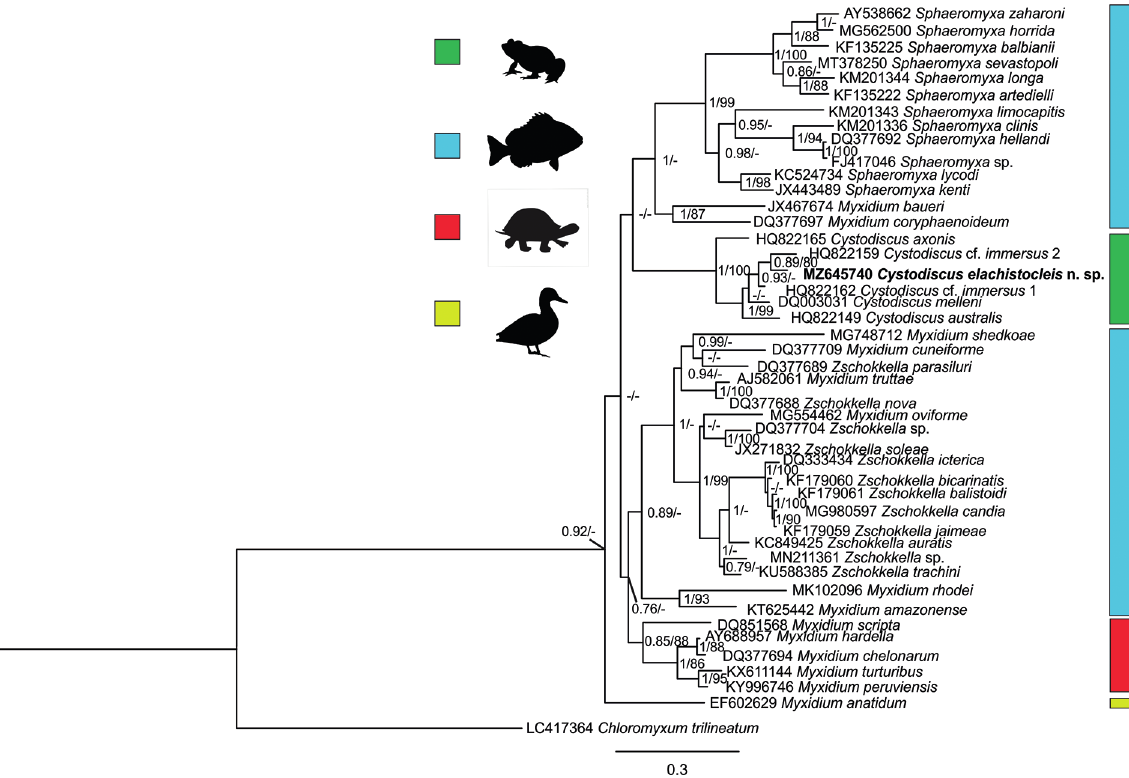
Fig. 3. Phylogenetic tree of Bayesian analysis based on partial SSU rDNA partial sequences showing the position of Cystodiscus elachistocleis sp. nov. (INPA79) among genetically similar species. Node numbers represent the Bayesian posterior probabilities and bootstrap (BI/ML). Values less than 0.7 are represented by dashes. The scale bar represents the number of substitutions per